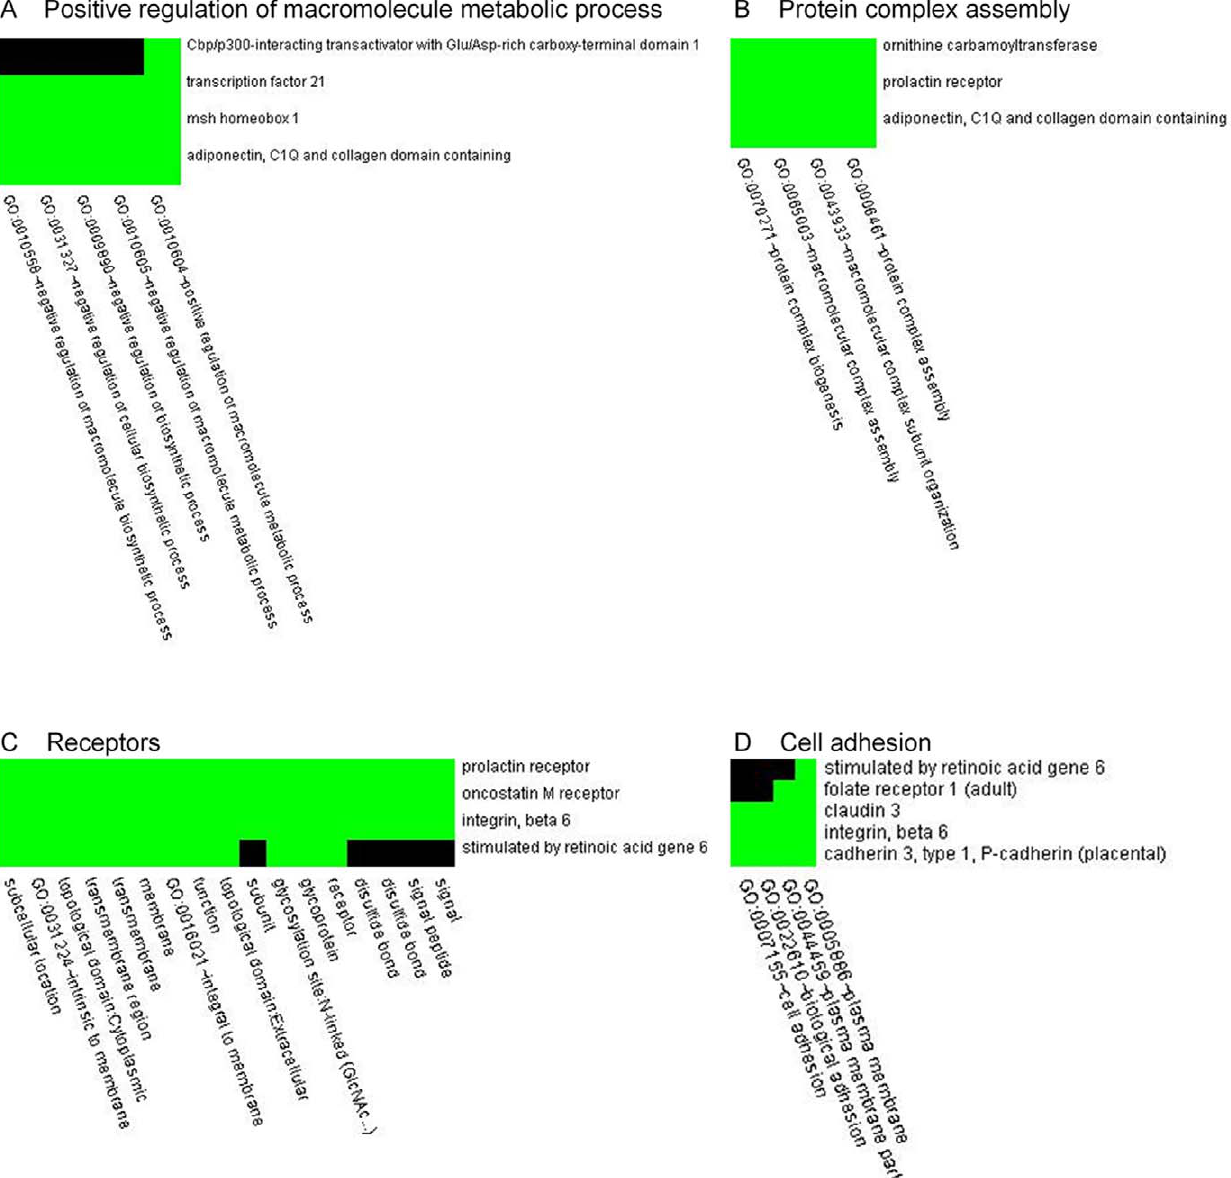
Figure 7. Functional annotation clustering. Green - corresponding gene-term association positively reported; black - corresponding gene-term association not reported yet. A: cluster of four genes: Tcf21 , Msx1 , Adipoq , Cited , which were grouped based on their involvement in positive regulation of the macromolecule metabolic process. B: cluster of three genes: Prlr , Otc , Adipoq , which were grouped based on their involvement in protein complex assembly. C: cluster of four receptors: Prlr , Osmr , Itgb6 , Ssta6 . D: cluster of three genes: Cldn3 , Itgb6 , Cdh3 , which were grouped based on their involvement in cell adhesion.